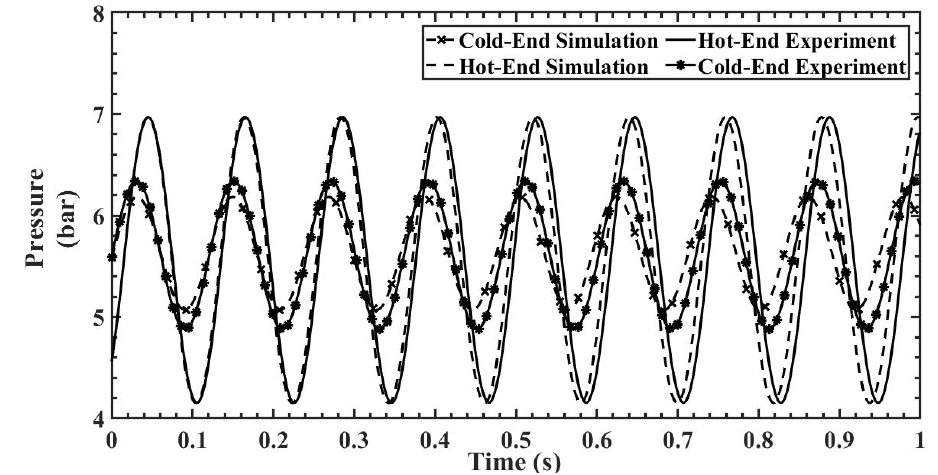
Figure 12. Hot- and cold-section pressure characteristics of a 300 mesh regenerator at 500 RPM.